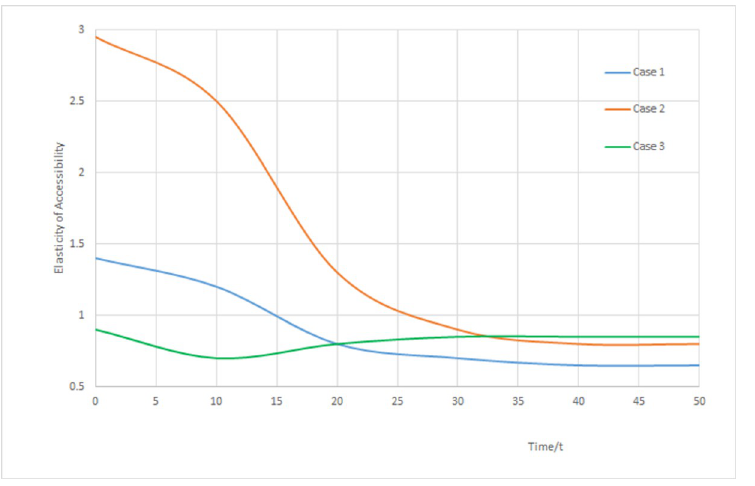
Fig 3. Elasticity results of